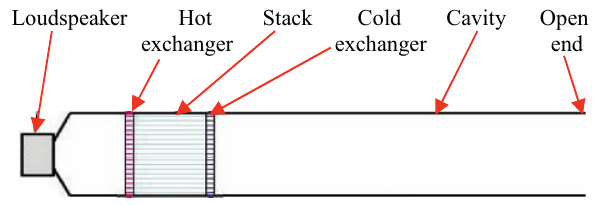
Figure 3. Schematic of thermoacoustic heat pump It is useful that hot heat exchanger and cold heat exchanger create as low obstacles for flowing working gas inside resonator as is possible.